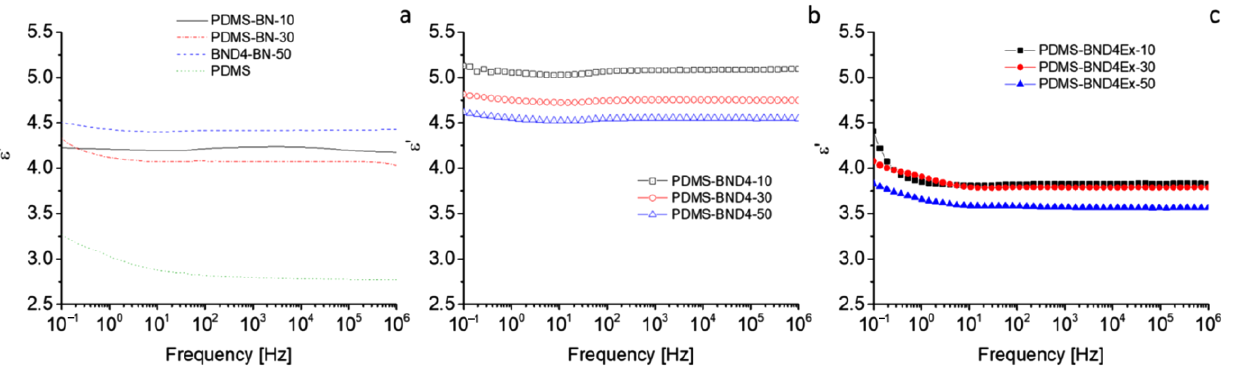
Figure 9. Dielectric spectra of the three composite series: ( a )—with the pristine BN powder; ( b )—with BN treated with D4; ( c )—with BN treated with D4 and exfoliated.